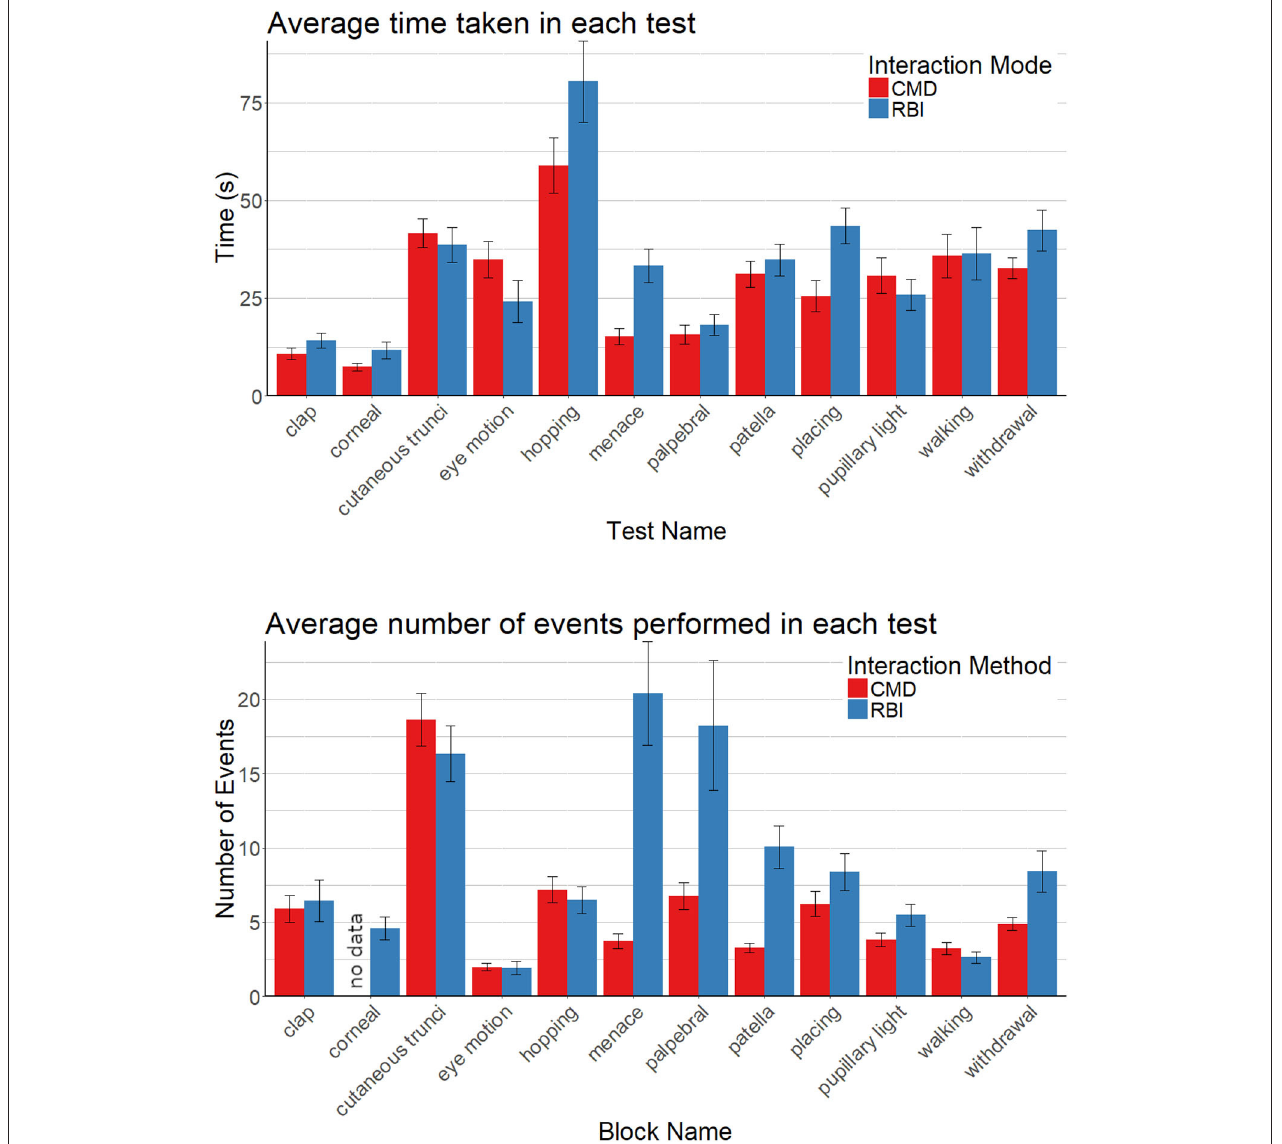
FIGURE 5 | Comparison of time spent in each test (top) and number of events completed (bottom) for the two interaction systems. Error bars are the 95% confidence